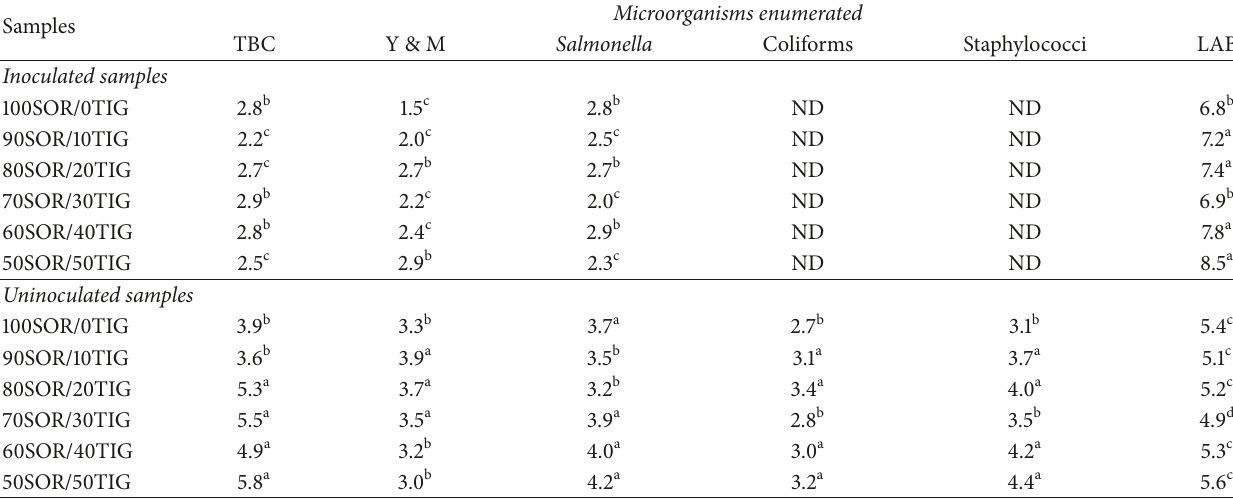
Table 3: Microbial counts (log CFUs/ml) of starter culture inoculated and uninoculated kunnu-aya .